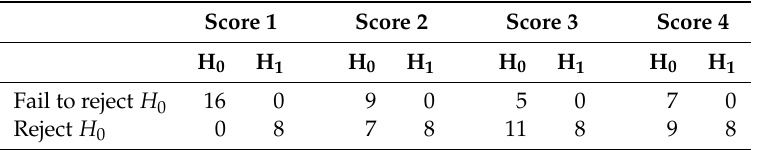
Table 12. Categorization of the samples with respect to the presence or absence of a fault and the result of the test for each of the four scores when the size of the samples to diagnose is ν = 50, L a = 50, and the sensors used are numbers 1,2,4,5,6 and 7.